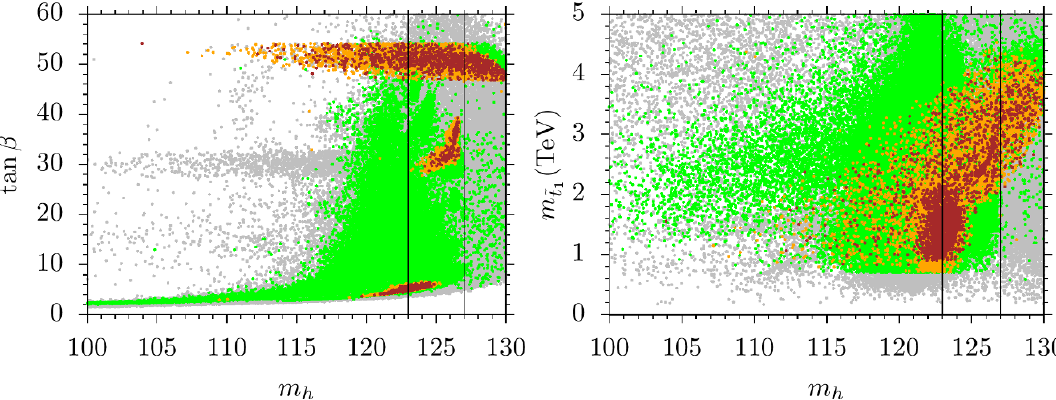
Figure 5 . Plots in the tan (cid:12) (cid:0) m h and m ~ (cid:0) m h planes. The color coding is the same as in (cid:12)gure 4. t 1 The Higgs mass bound is not applied, but it is indicated with two vertical lines at m h = 123 GeV and m h = 127